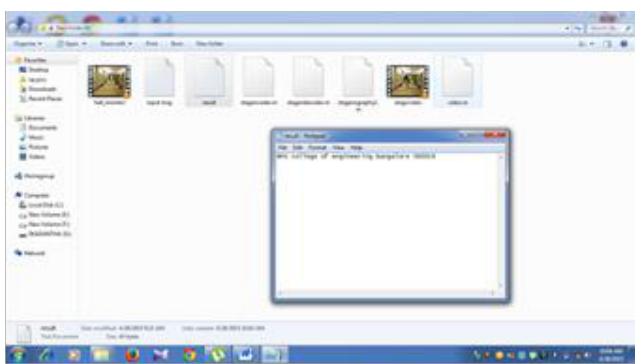
Figure . 14 Recovered text file is saved as,”.txt”in a specified